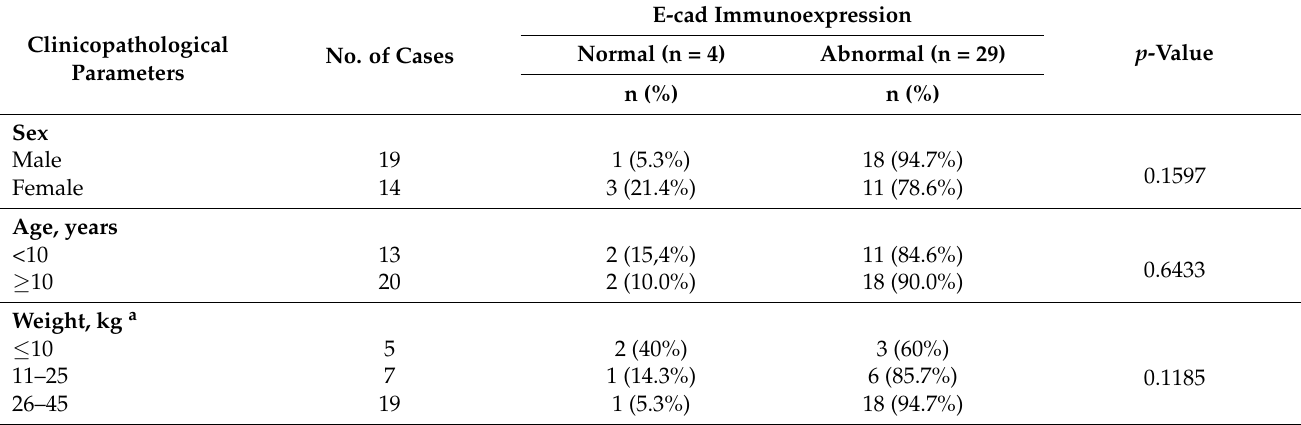
Table 3. Relationship between E-cad expression in 33 canine gastric carcinomas and clinicopathologi- cal